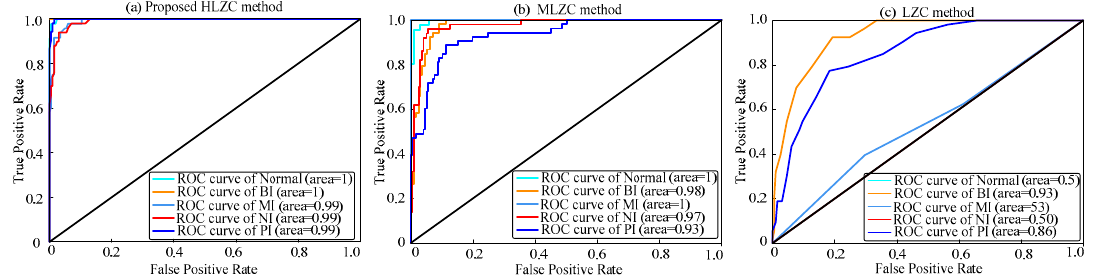
Figure 18. Performance comparison between three methods: ( a ) HLZC-support vector machine (SVM), ( b ) MLZC-SVM, and ( c ) LZC-SVM.